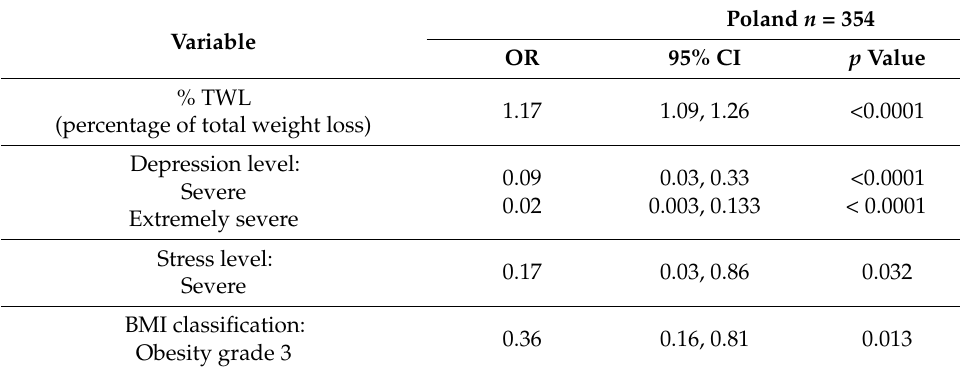
Table 5. Multiple logistic regression model results for the risk factor of adherence in the field of obesity treatment in Poland ( n = 354).